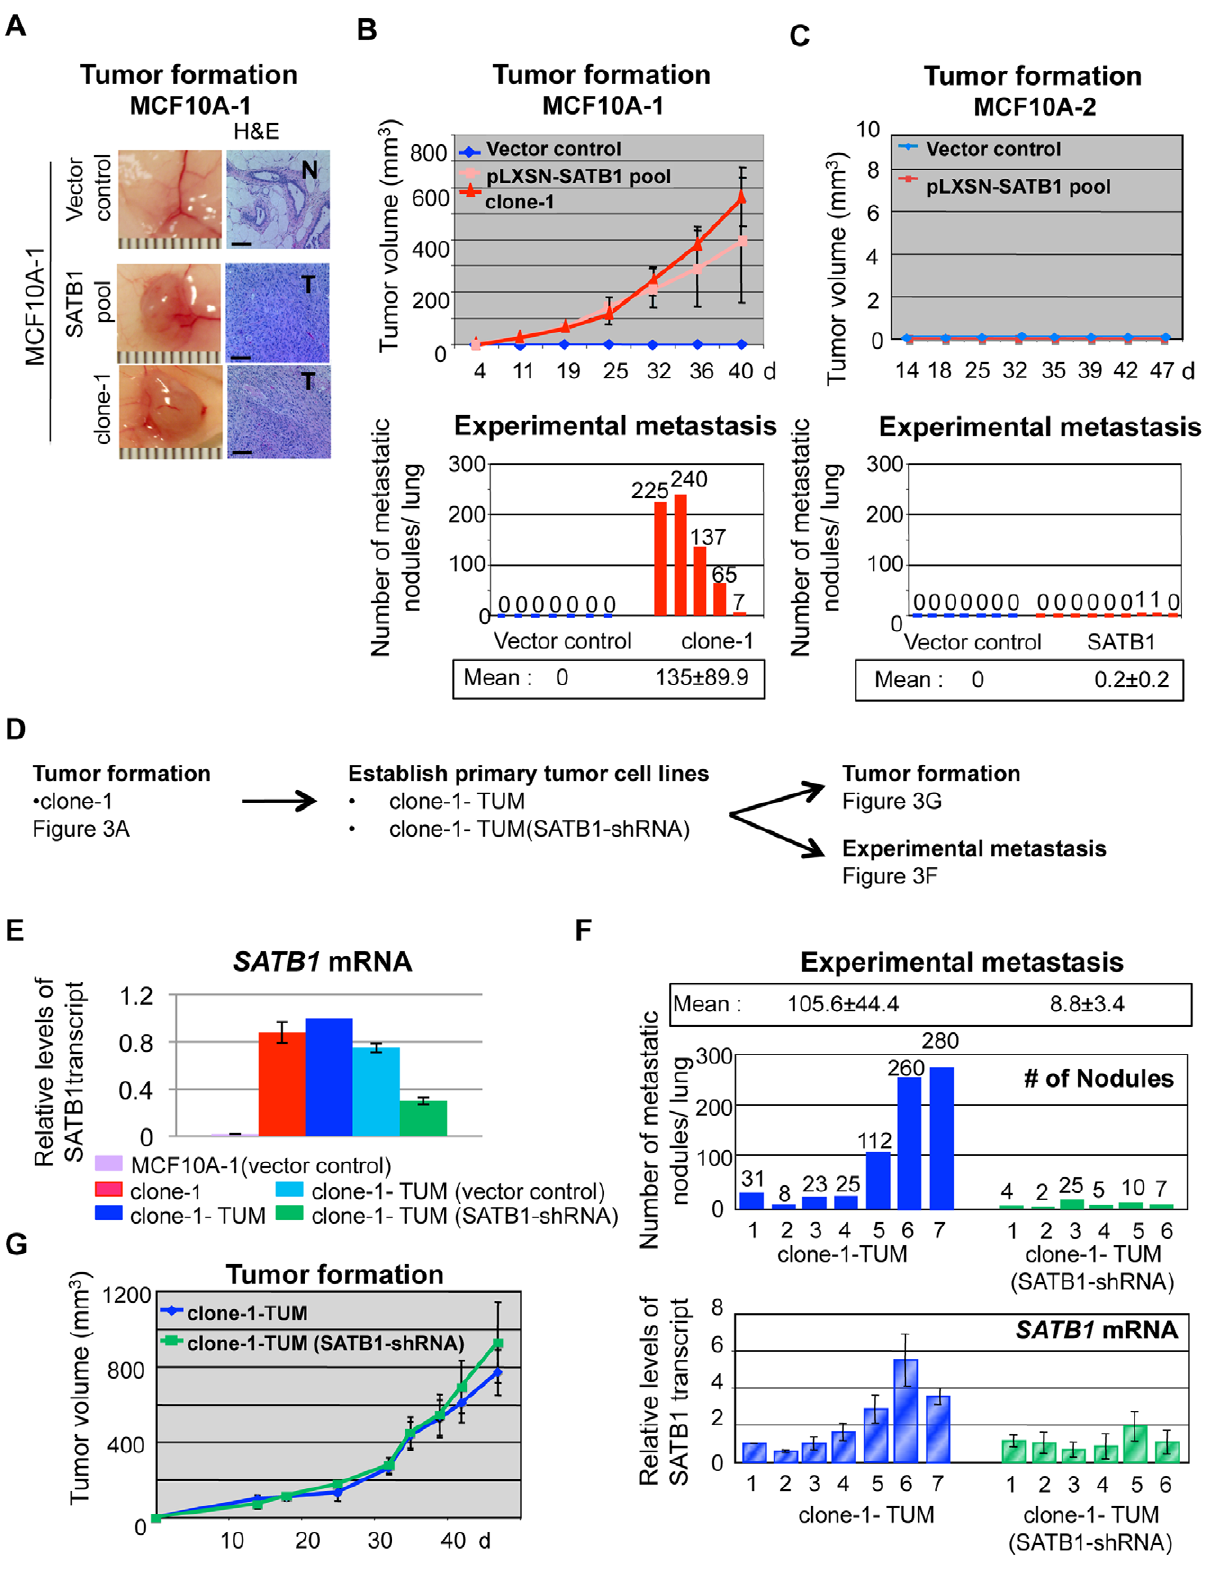
Figure 3. Ectopic expression of SATB1 in MCF10A-1 cells induces tumor growth and lung colonization. A ) (Left) Representative photographs of tumors formed by vector control and SATB1 overexpressing (pooled population and clone-1) MCF10A-1 cells injected into the mammary fat pad of nude mice. (Right) Corresponding tumor sections stained with haematoxylin and eosin. T, tumor; N, normal breast tissue. Scale bar, 80 m m. B ) (Top) Mean tumor volumes as formed in ( A ). Note that the tumors derived from clone-1 grew at the fastest rate. Each data point is